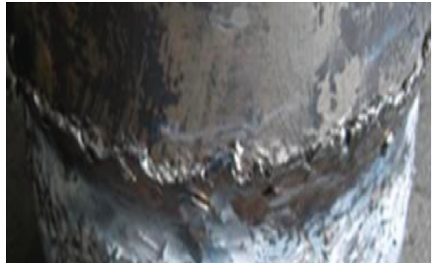
Figure 18: Spinning peeling defect.